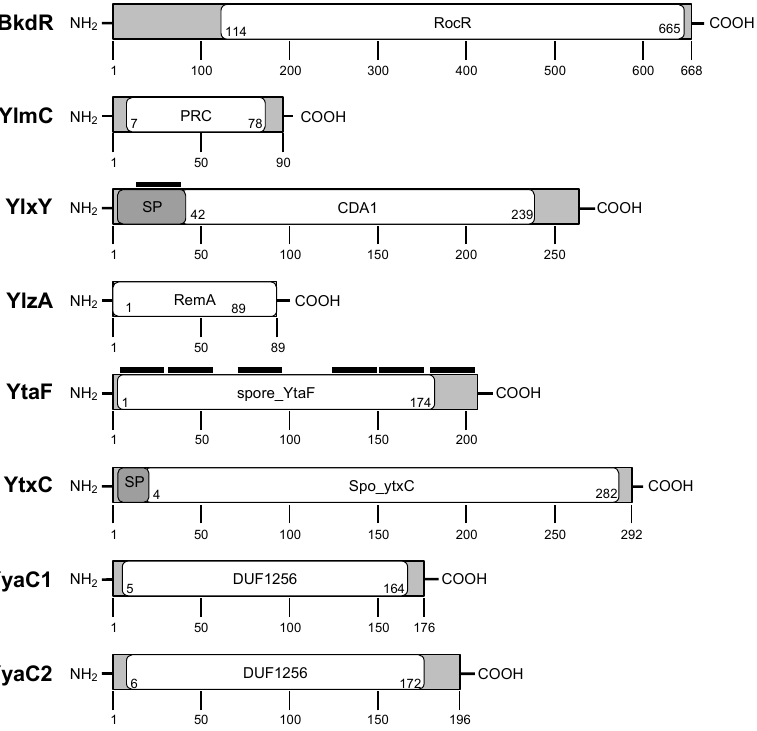
Figure 2. Schematic diagram of protein structure and predicted domains in C. perfringens strain SM101. SP denotes signal peptide sequence. The black bar on top of the protein indicates the transmembrane domain.